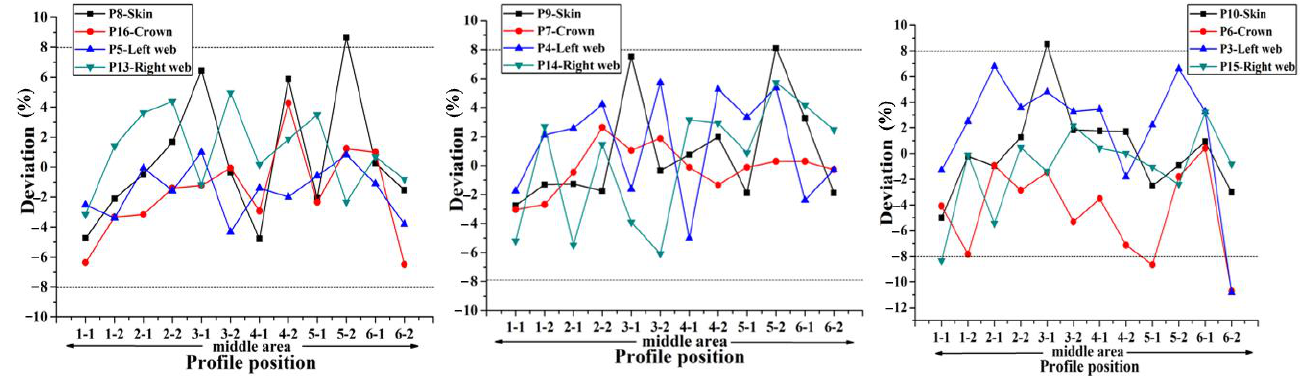
Figure 13. Comparison of dimensional stability of stringer manufactured by 50 HC bladder.